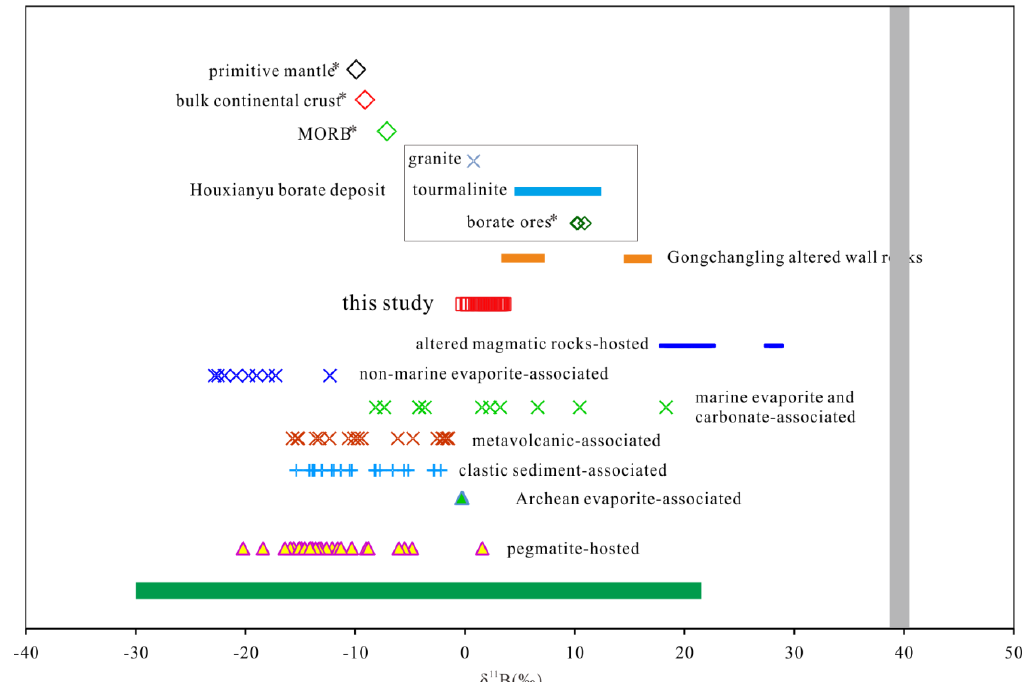
Figure 10. Comparison of the tourmaline δ 11 B values of the interlayered tourmaline-rich rocks in the Zhaoanzhuang iron deposit with compiled data for non-marine evaporite-associated [154], marine evaporite and carbonate-associated [77], metavolcanic-associated [154], clastic sediment-associated [154], Archean evaporite-associated [151], altered magmatic rocks-associated [85], and pegmatite-hosted [152] tourmaline. The tourmaline δ 11 B values of the tourmalinite and granite in the Houxianyu borate deposit, northeastern North China Craton [155,156] and the altered wall rocks in the Gongchangling high-grade iron ore deposit, Anshan-Benxi area of the North China Craton (Wang Qian, unpublished data) are also plotted for comparison. Houxianyu borate deposit data with * symbol indicate δ 11 B values of borate ores [155]. Data with * symbol indicate the average δ 11 B composition of the primitive mantle [148], bulk continental crust [149], and uncontaminated mid-ocean ridge basalts (MORB) [149]. The solid green lateral band represents the δ 11 B variations of tourmaline in natural rocks [76,77,90]. The solid grey vertical band represents a δ 11 B value of +39.6 ± 0.04‰ [144].